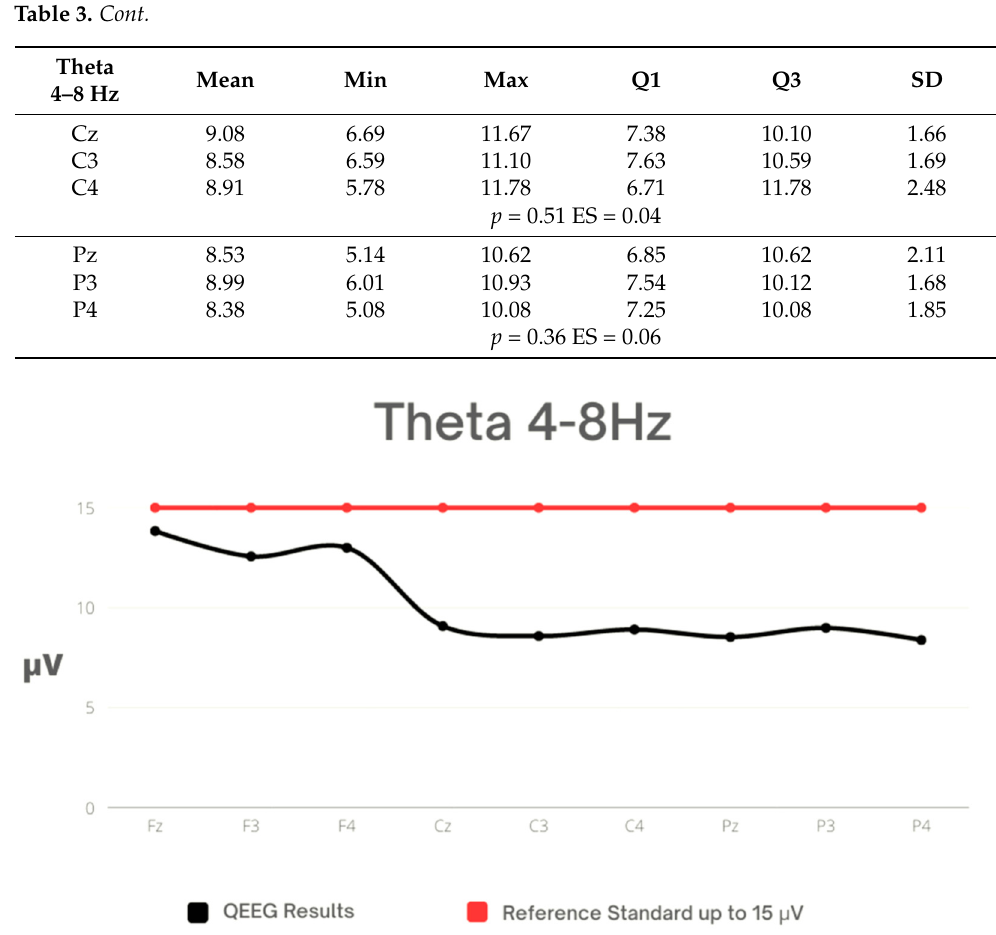
Figure 2. Mean values for Theta against reference standard.